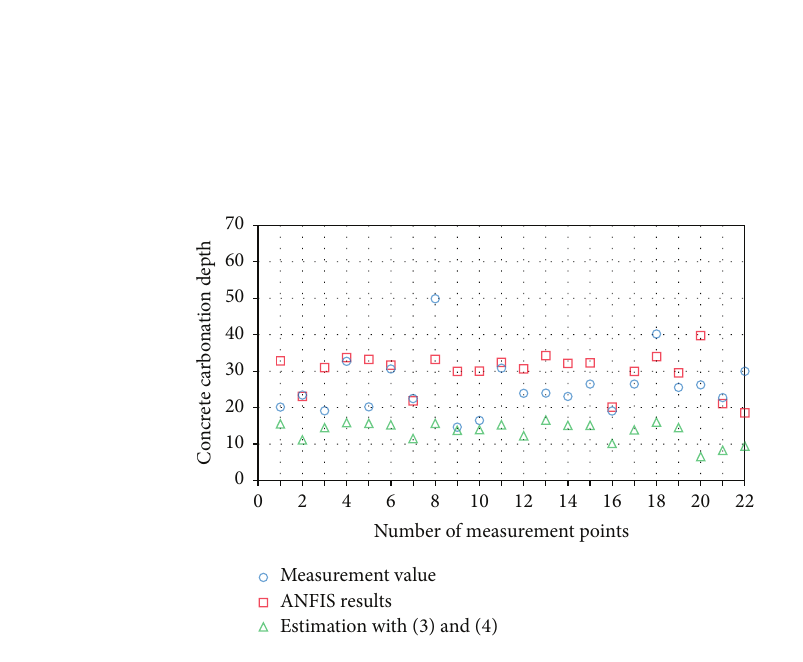
Figure 8: ANFIS results with respect to input parameters.